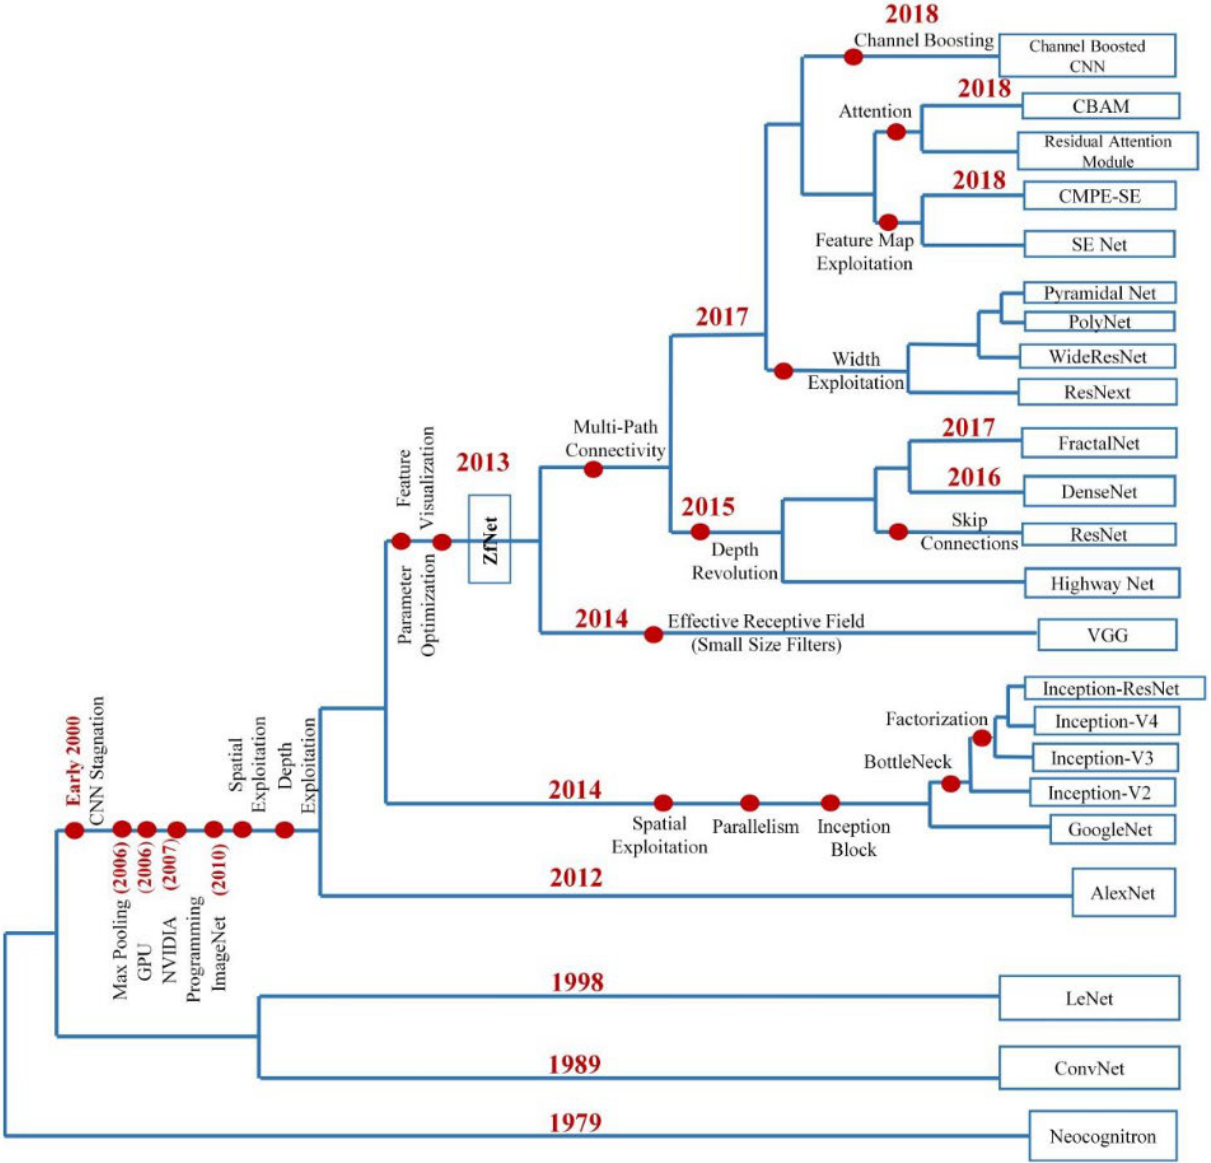
Figure 9. History of CNN variations arranged in chronological order.